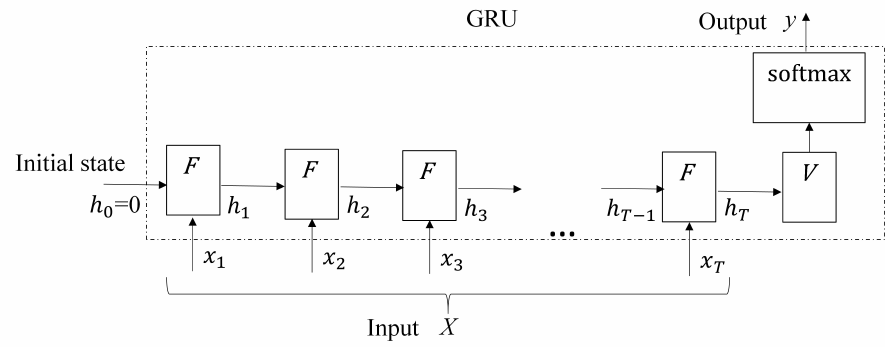
Figure 1. The summary of the operations in (1), (2), (3), and (4). These operations can be viewed as a function F given by (5), which takes h i − 1 and x i as the inputs, and produces output h i . The bias vectors b j , j = z , r , h , are omitted for the sake of simplicity.